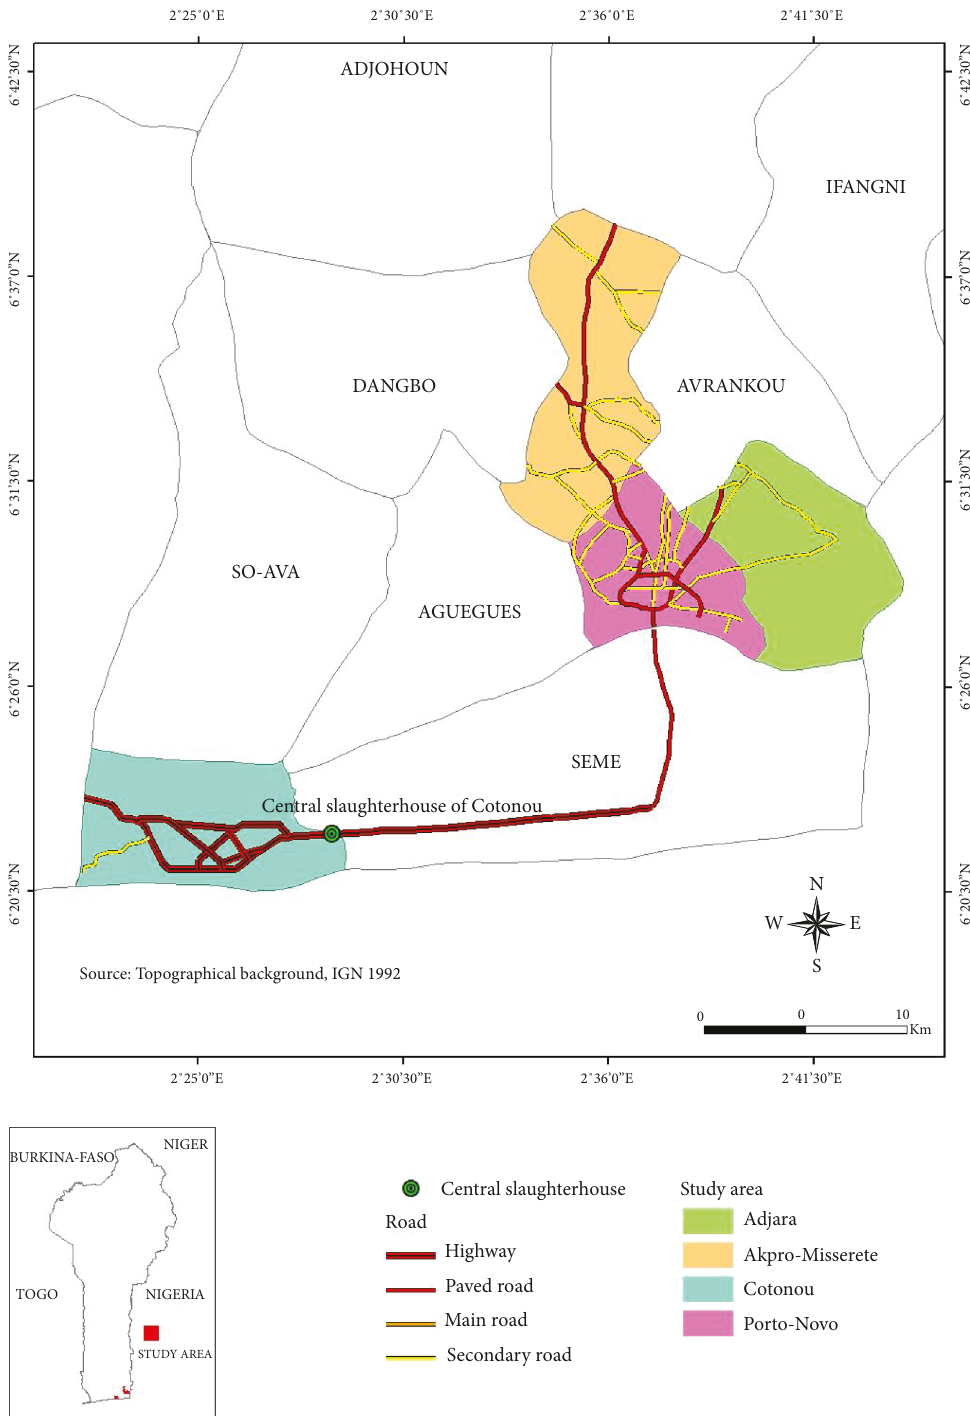
Figure 1: Map of southern Benin showing the study area and the central Cotonou